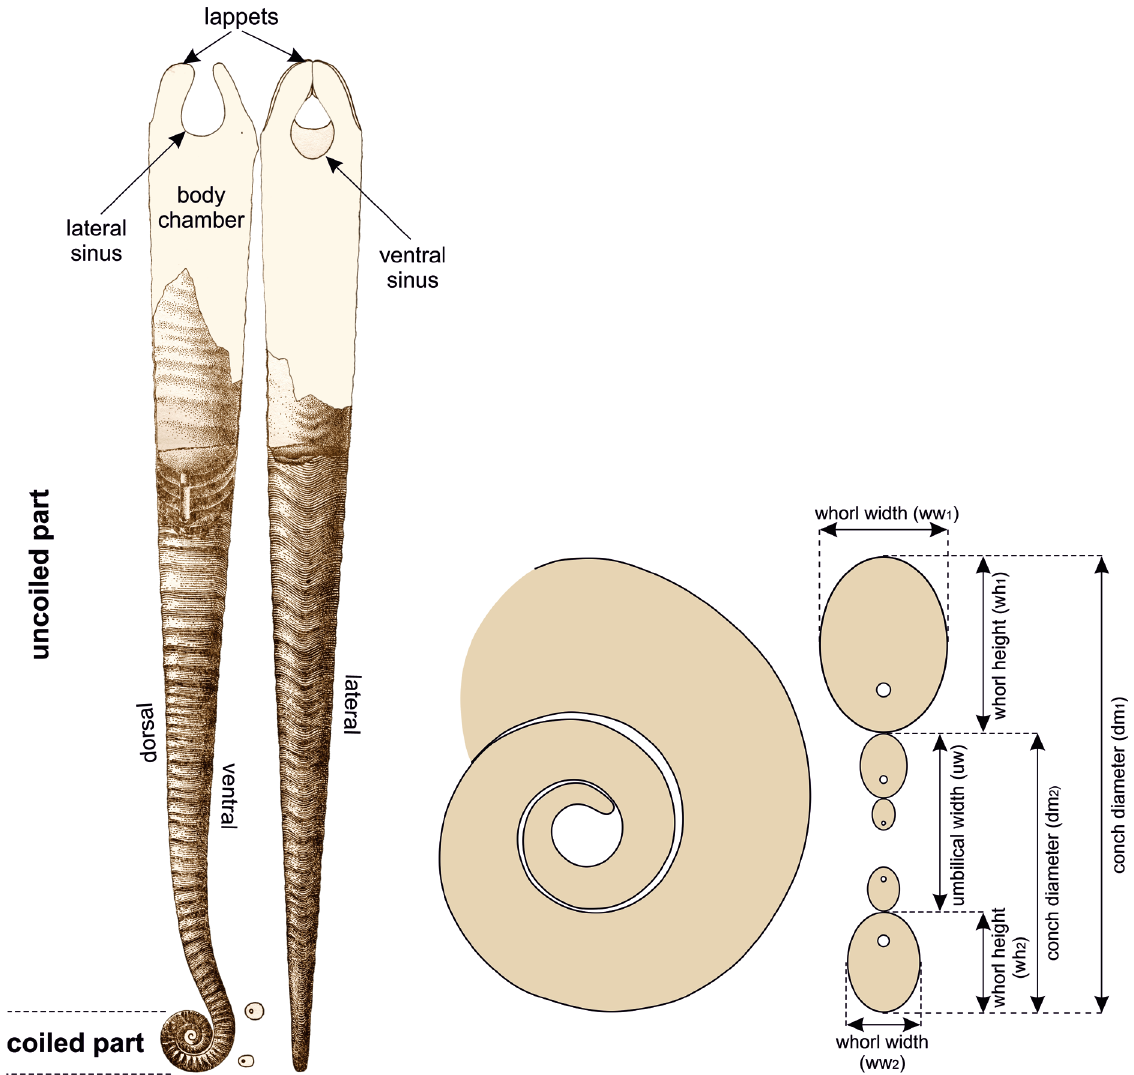
Fig. 7. Morphological terminology used in this study to describe lituitid specimens; drawing from Dzik